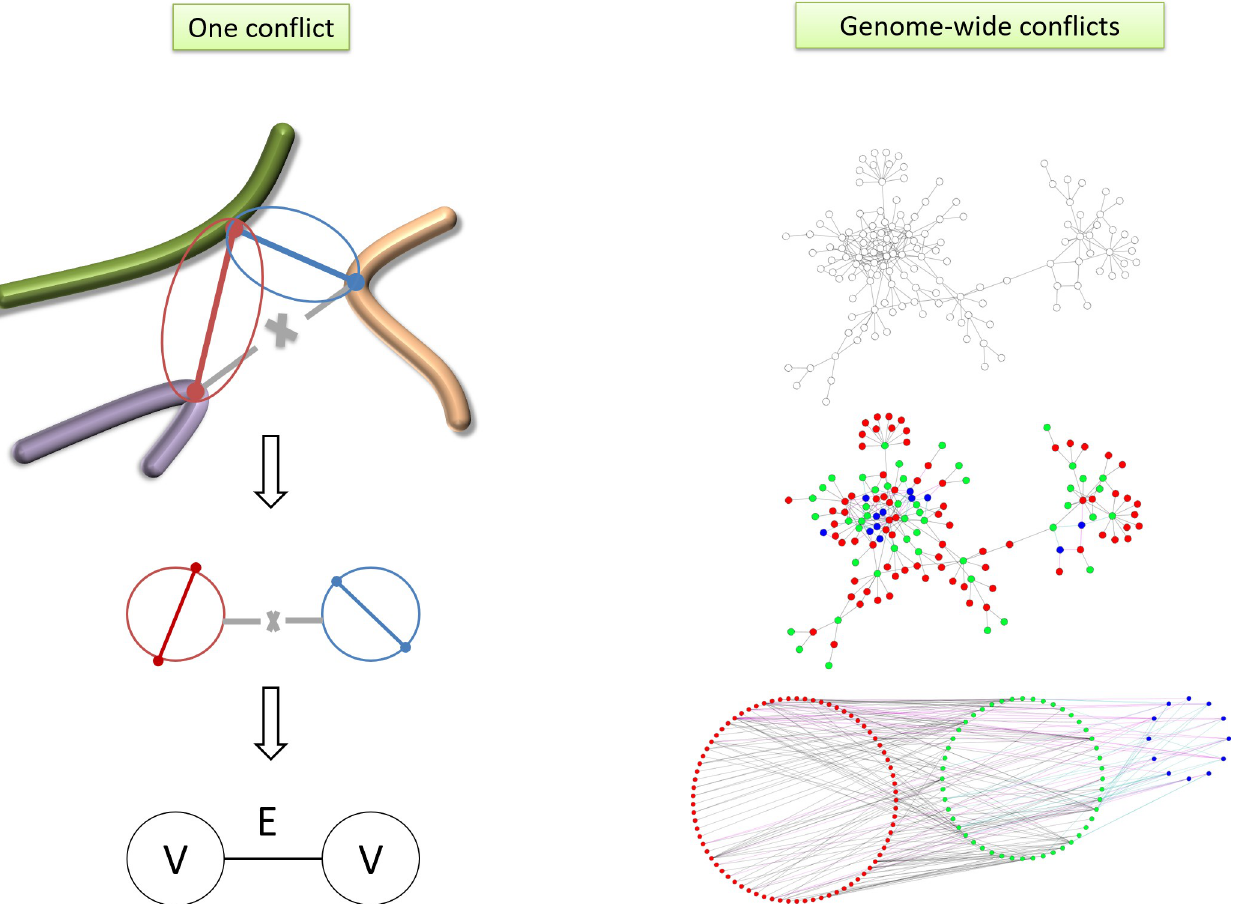
Fig 2. Resolving contact conflicts. Left: Generating the conflict graph, where the vertices are contacts and edges are conflicts. Right: Assuming a mixed population of cells in the sample, we resolve the conflict by coloring the (V,E) conflict graph.